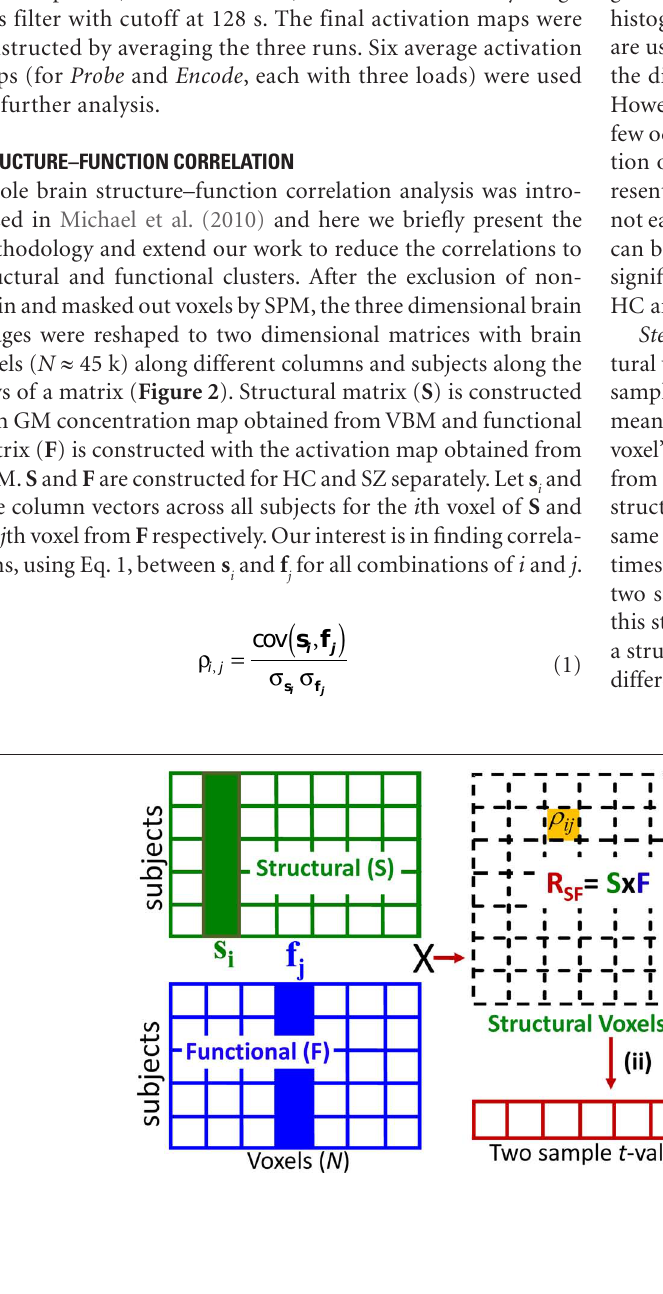
how each structural voxel’s mean correlation with all functional voxels is different FIguRe 2 | Computing the structure–function cross correlation (RSF) between HC and SZ. (iii) Contiguous regions of this t -map are grouped to matrix and step-wise reducing into structural and functional clusters. Gray construct structural clusters (iv) For each structural cluster, compute the matter concentration voxels are vectorized and placed along the columns and correlation between its mean and all functional voxels (shown for only one subjects along the rows to construct the structural matrix (S) . Similarly activation structural cluster). (v) Contiguous regions are grouped to construct functional maps from the fMRI task are used to make the functional matrix (F) . The cross clusters (shown for only one correlation matrix ( R ) is reduced (i) to a histogram. (ii) Compute a t -map to find SF